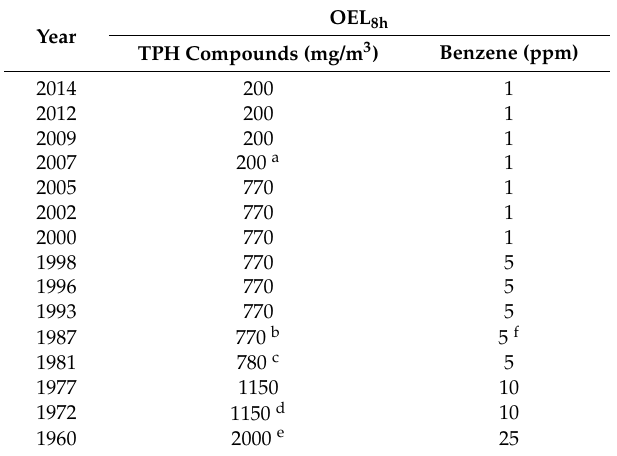
Table 1. Finnish Occupational Exposure Limit (OEL 8h) for benzene and TPH compounds, 1960–2014. OEL 8h Year TPH Compounds (mg/m 3